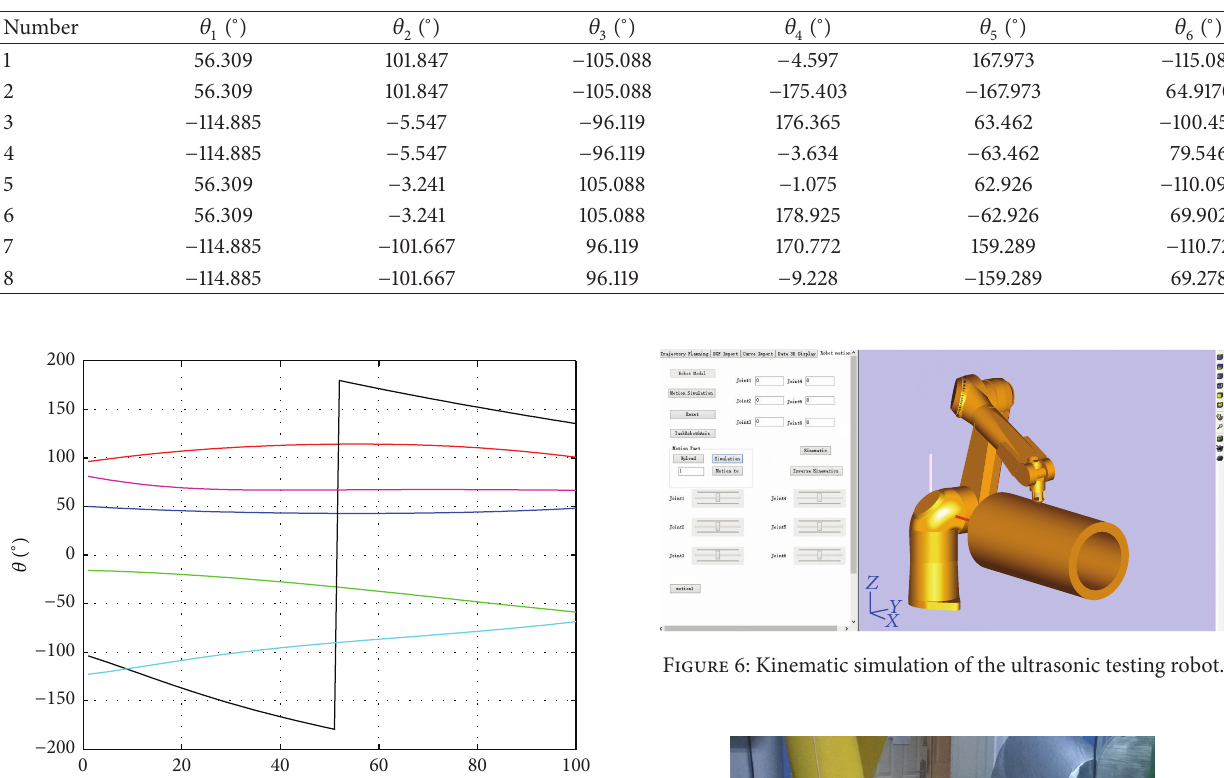
Table 2: Solutions of inverse kinematics.